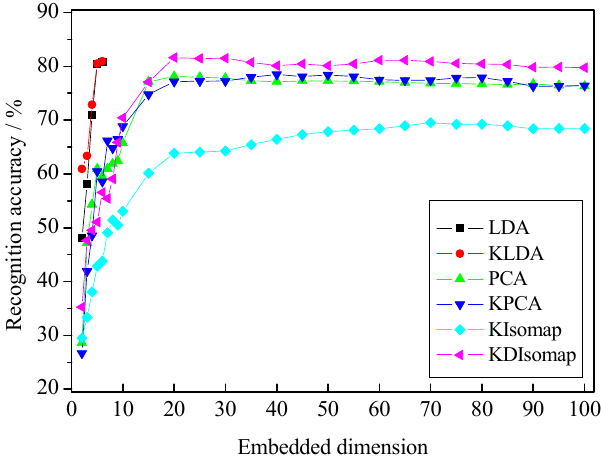
Figure 7. Performance comparisons of different methods on the JAFFE database.